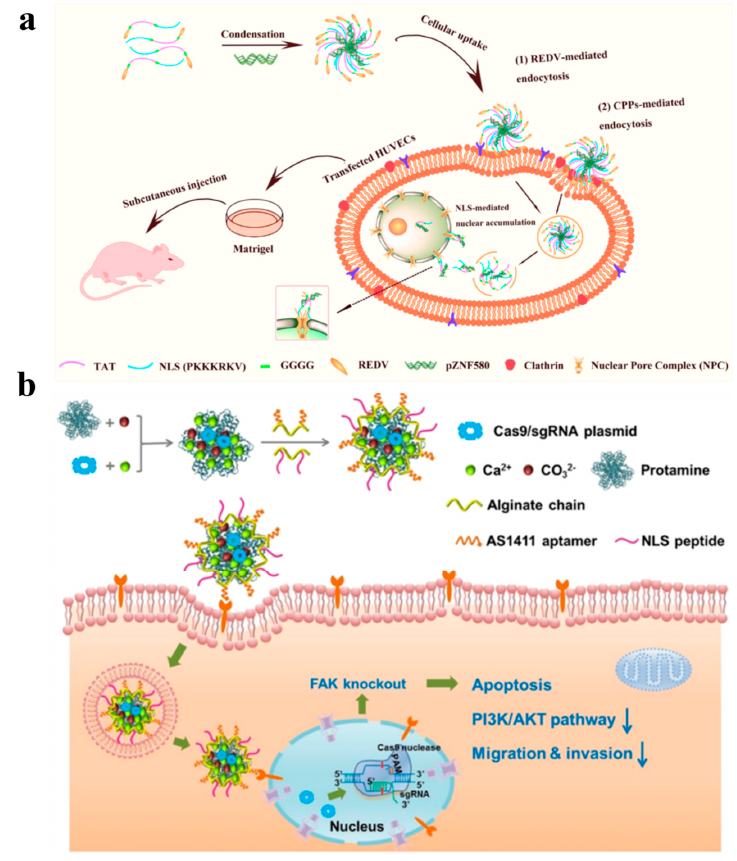
Figure 6. ( a ) The REDV-G4 -TAT-G4-NLS peptide assembles with pZNF580 plasmid to form nanocom- plexes, which are transported to endothelial cells by the targeting effect of REDV. After the transmembrane and endosomal escape, the complexes enter the nucleus by the action of NLS to promote the expression of pZNF580 plasmid and enhance the revascularization ability of cells. Re- printed with permission from Ref. [59]. Copyright 2017, American Chemical Society. ( b ) The Cas9/sgRNA plasmid gene delivery system was prepared by the self-assembly method, which can specifically deliver the plasmid to the nuclei of tumor cells by the targeting of NLS, and knock down the protein tyrosine kinase 2 (PTK2) gene to the down-regulated local adhesion kinase (FAK). Re- printed with permission from Ref. [60]. Copyright 2019, American Chemical Society. In addition to adding MP NLS to various nonviral vectors to achieve efficient nuclear delivery of therapeutic DNA, BP NLS composed of two or more positively charged amino acid clusters have also been developed and used for gene delivery. Matschke synthesized a modified NLS dimer structure, NLS-Ku7O 2 . Highly efficient nuclear transport and trans- genic expression were realized by co-assembling this BP NLS-Ku7O 2 with PEI and DNA into a ternary gene carrier complex [63].